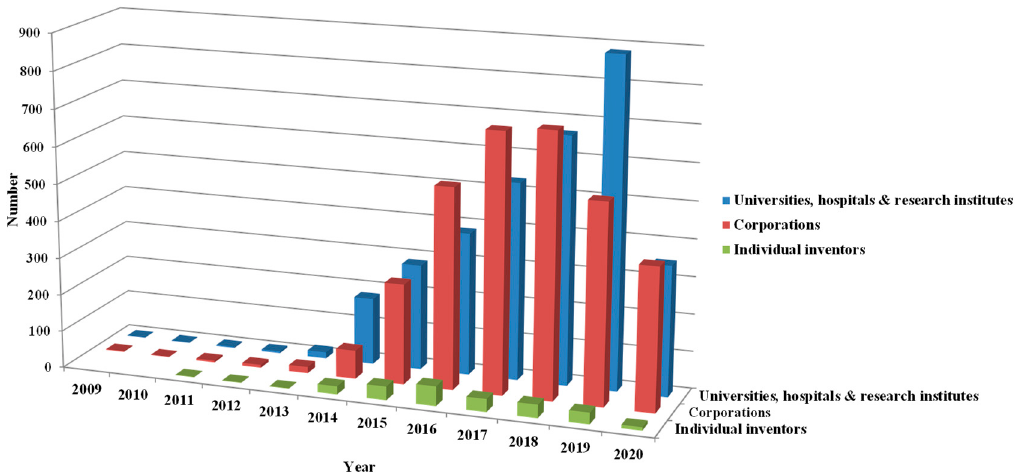
Figure 13. The contributor types of 3D printing patents.